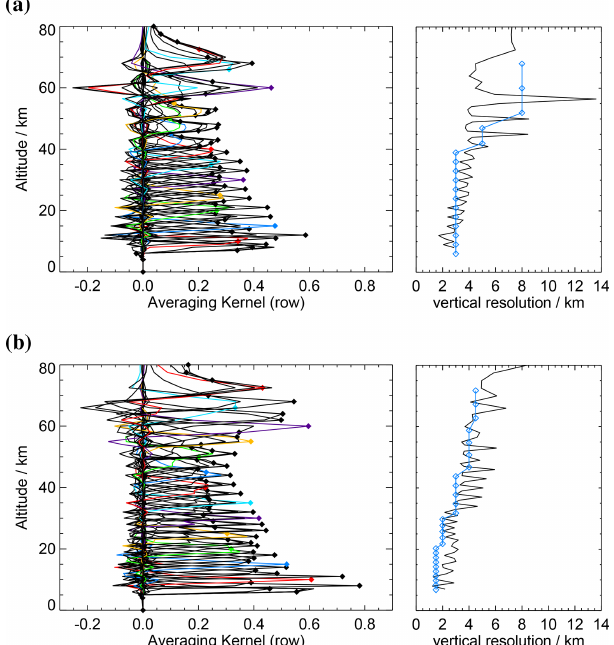
Figure 3. Rows of the averaging kernel matrix for ozone profiles recorded during the FR and RR measurement period (left panels) and the corresponding vertical resolution, as calculated from the full half-width of the kernel rows (right panels, black curves). Ker- nel rows are coloured every 5km up to 60km. FR data (a) are taken from 14 January 2003 (Envisat orbit 4577) at 46.1 ◦ N, 155.1 ◦ W and at solar elevation 17.6 ◦ ; RR data (b) are from 4 January 2009 (or- bit 35800) at 48.4 ◦ N, 116.4 ◦ E and at solar elevation 14.6 ◦ . In the right panels the measurement grid widths are shown as blue curves with diamond